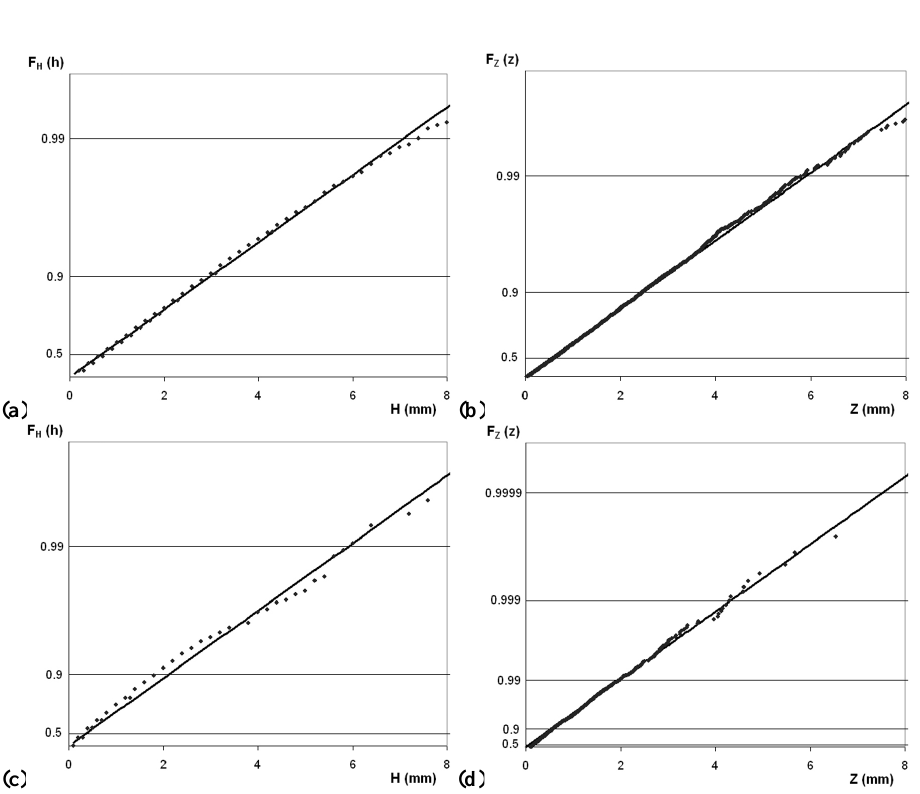
(cid:12) (cid:12) H i + 1 > 0 ∩